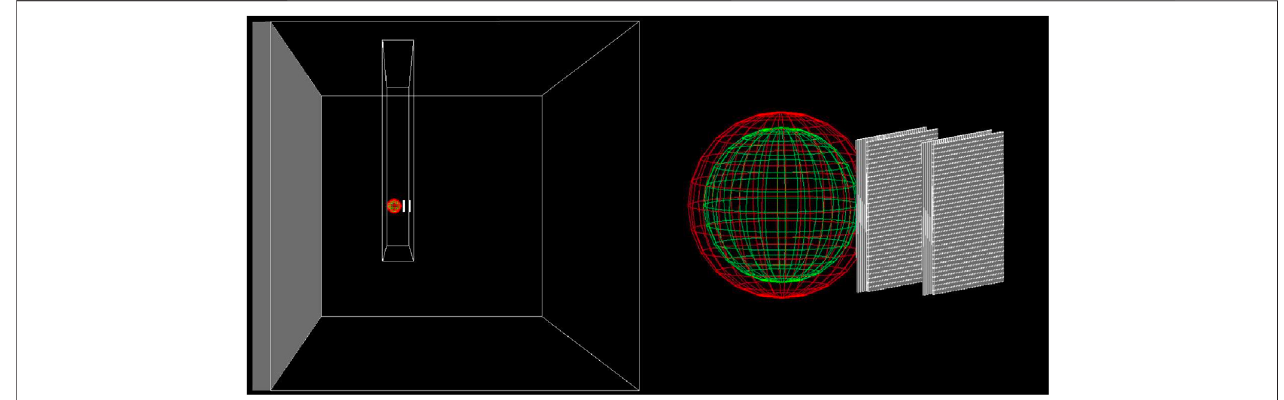
FIGURE2| 3DschemeofthegeometryusedforallGeant4simulations.BoththeTEPCandthefour24-stripsLGADsarecontainedinPMMAbox fi lledwithair.The box is placed inside a water phantom, whose walls are made of PMMA. A broader view is show in left panel, while a zoom on HDM is illustrated in right panel.